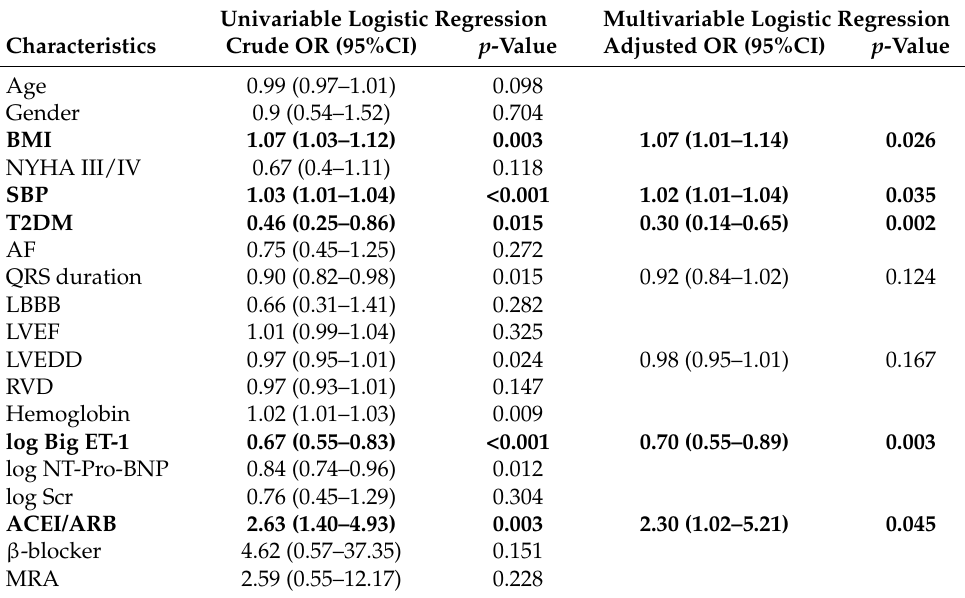
Table 2. The association between variables and LVRR at univariable and multivariable logistic regression. Univariable Logistic Regression Multivariable Logistic